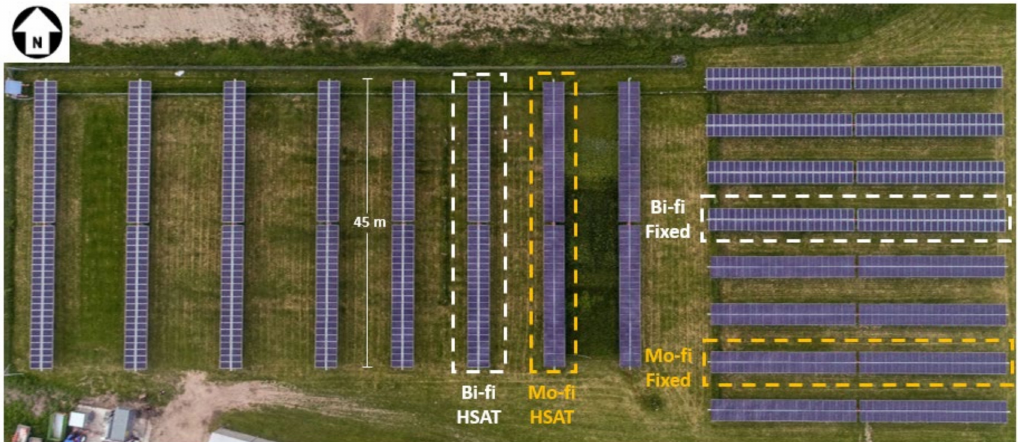
Figure 1. Aerial view of the test facility. There are eight horizontal single-axis trackers (HSATs) and eight fixed-tilt rows. The bifacial (bi-fi) and monofacial (mo-fi) systems investigated in this paper are highlighted in white and orange,